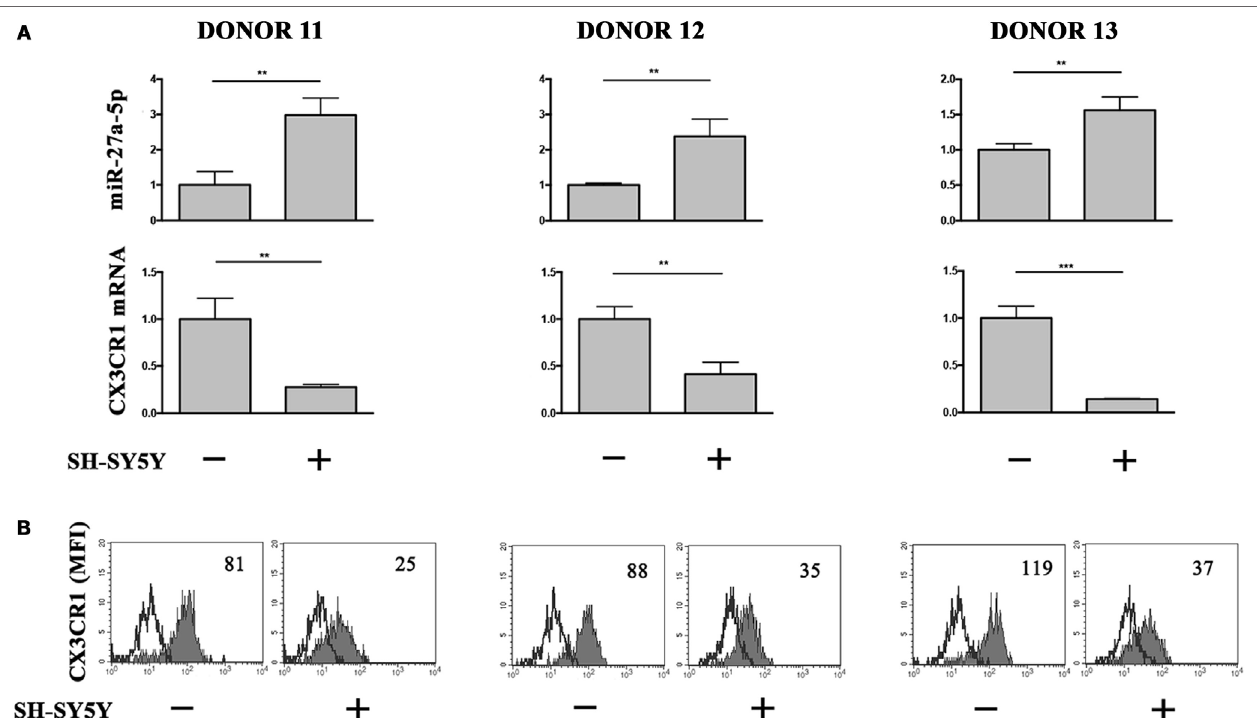
FigUre 6 | miR-27a-5p and CX 3 CR1 expression in NK cells cocultured under transwell conditions with SH-SY5Y neuroblastoma cell line. (a) miR-27a-5p and CX 3 CR1 mRNA expression of SH-SY5Y-conditioned NK cells from three healthy donors (donors 11, 12, and 13). Data in triplicate from each donor are shown. RNU44 and GAPDH were used as reference controls, respectively. ** p < 0.01; *** p < 0.001. (B) Cytofluorimetric analysis of CX 3 CR1 expression in NK cells from the same donors. White profiles refer to cells incubated with isotype-matched mAbs. Value inside each histogram indicates the median fluorescence intensity